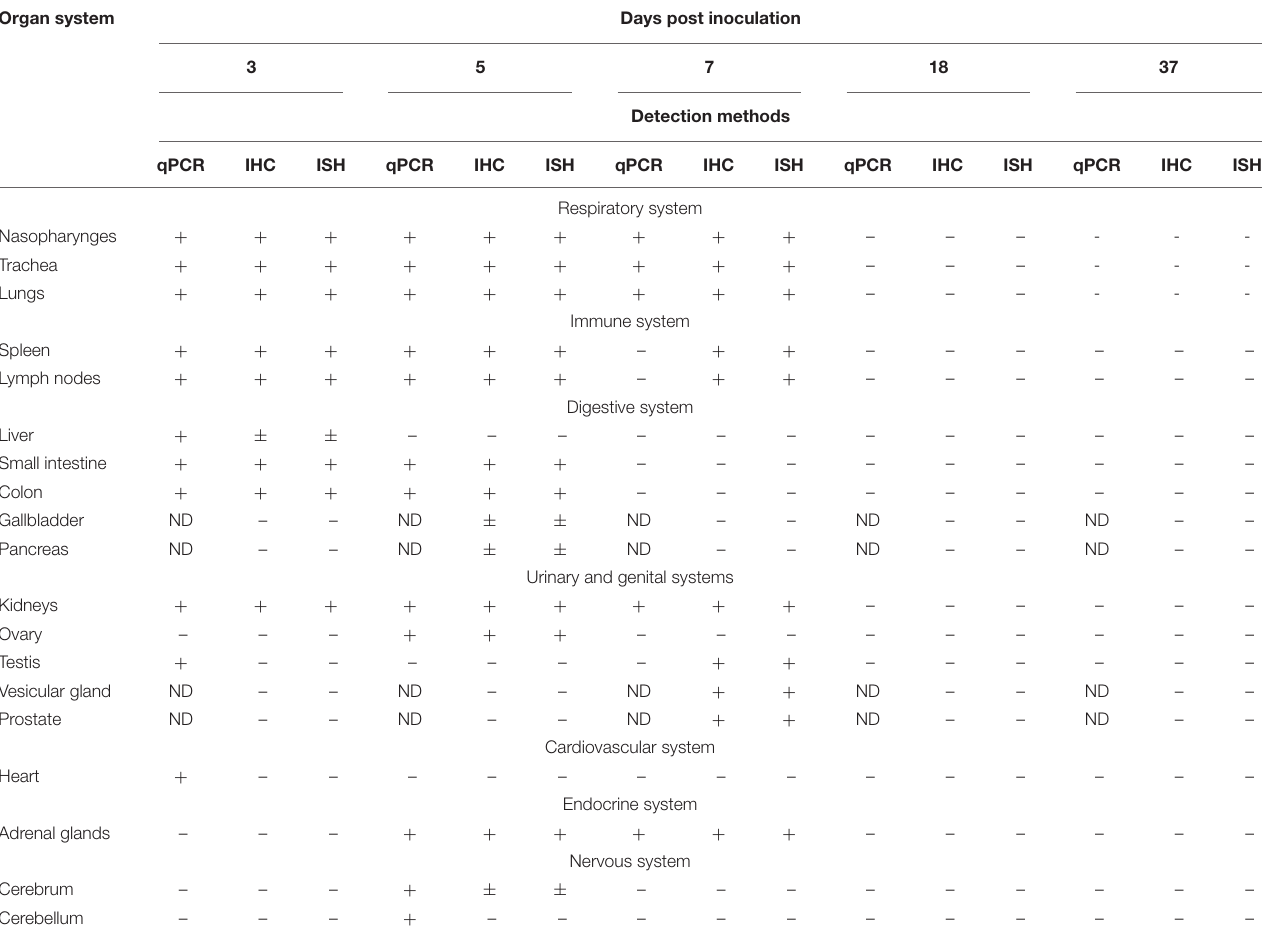
TABLE 1 | The infectious multi-organs in hamsters with COVID-19. Organ